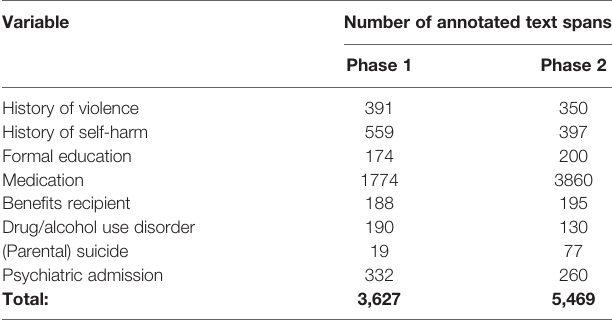
TABLE 2 | Summary of annotated electronic health records documents used to train the named entity recognition model. Variable